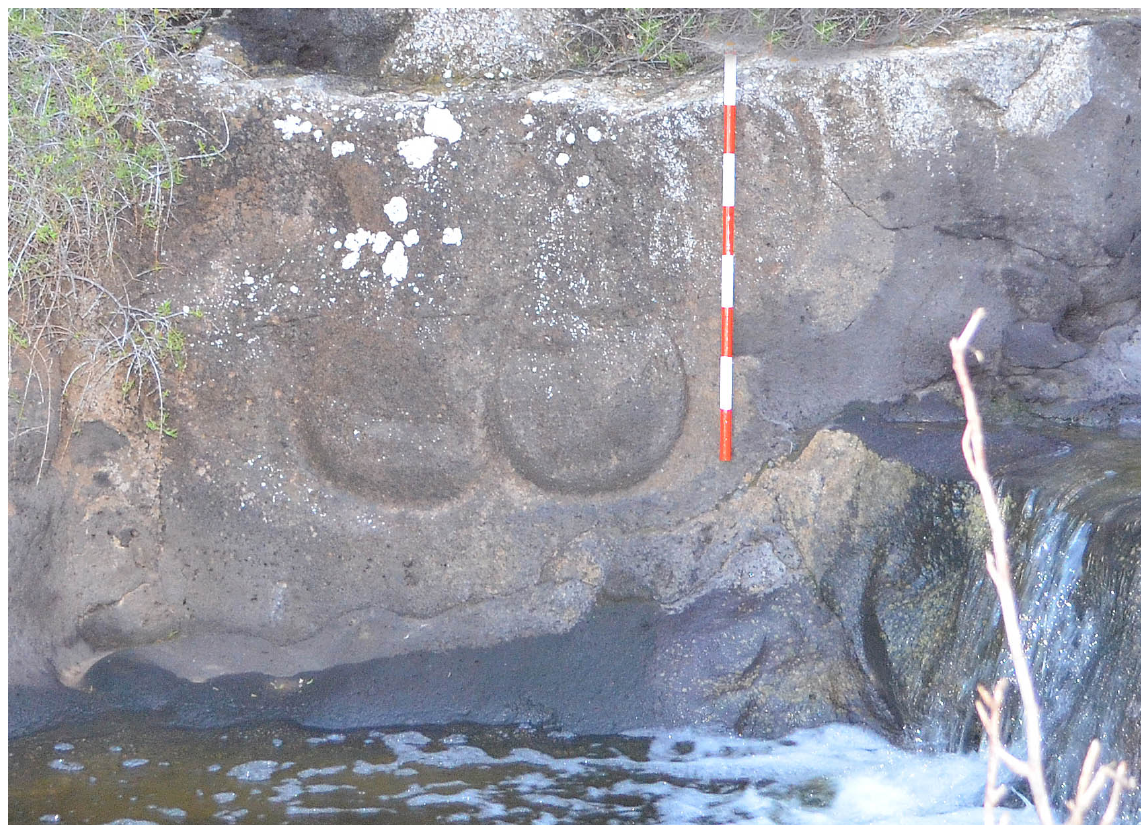
Figure 3. Detail of the basalt quern quarry in the Cardones Ravine (Arucas Municipality) during the rainy season. The quarry face is covered with circular extractions corresponding to negatives of rotary querns measuring less than 40 cm in diameter.